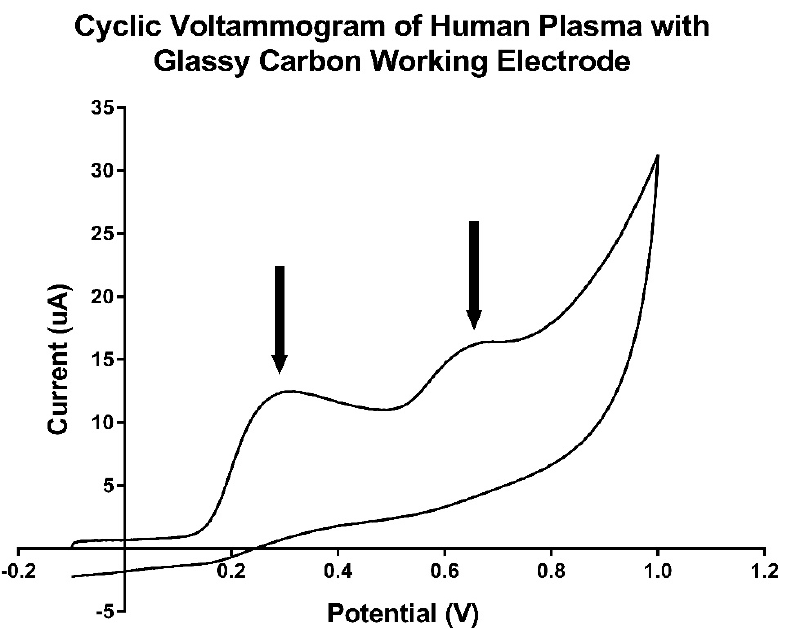
Figure 2. Example of cyclic voltammogram of human plasma with glassy carbon WE, Ag/AgCl RE and platinum CE. Scan range: − 0.1 V to 1 V, as a scan rate of 100 mV/s. Black arrows indicate two intrinsic voltammetry peaks corresponding to redox-active molecules in the sample (see Section 3.3).